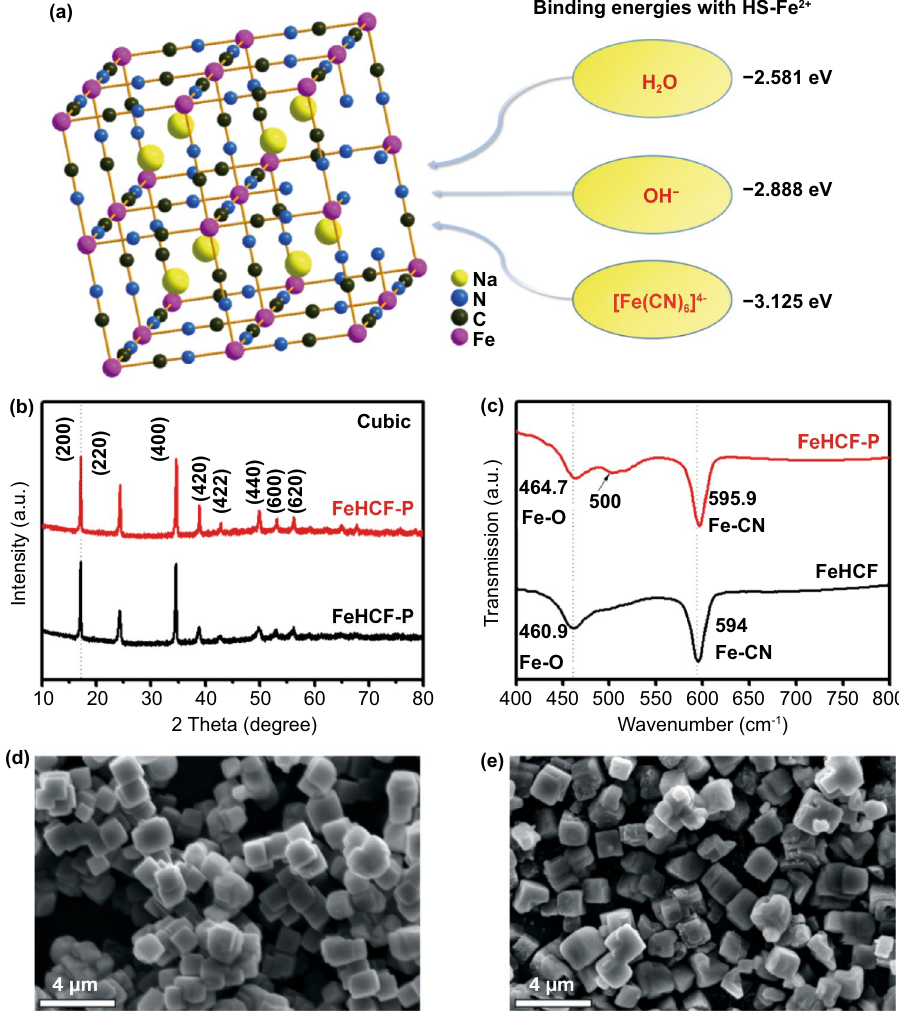
Fig. 1 a Binding energies between HS-Fe 2+ in FeHCF with different ligands. b XRD patterns and c FTIR spectra of FeHCF and FeHCF-P. SEM images of d FeHCF and e